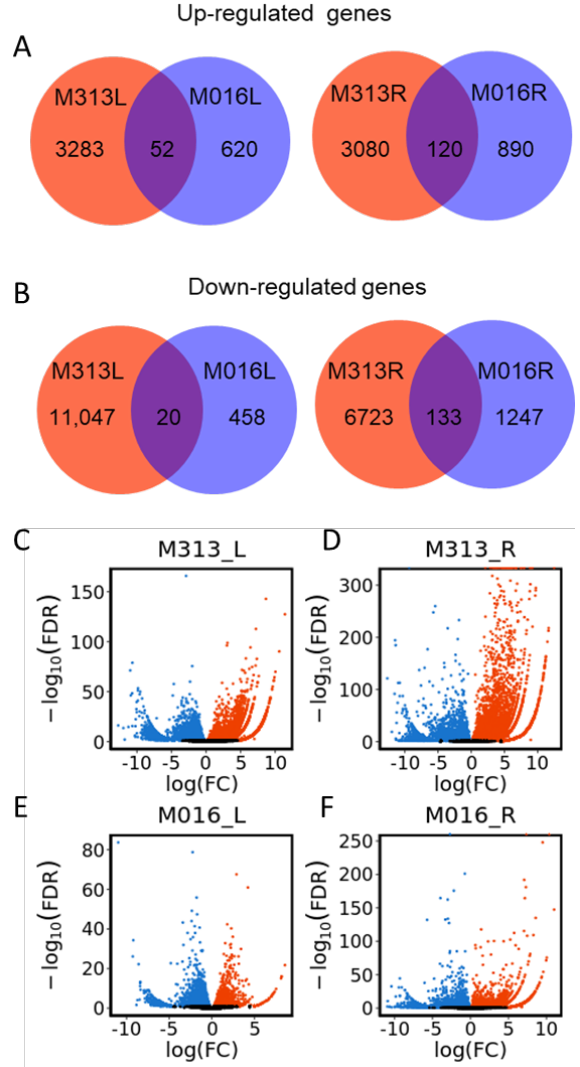
Figure 1. Analysis of DEGs in leaves and roots of M. lutarioriparius with different ploidy levels under drought stress. ( A , B ) Venn diagram of up-regulated ( A ) and down-regulated ( B ) genes in leaves and roots of M. lutarioriparius with different ploidy level. Red circle represents diploid (M313) and blue circle represents tetraploid (M016), L and R represent leaves and roots, respectively. ( C , D ) The volcano plot of the DEGs in the leaves ( C ) and roots ( D ) of diploid. ( E , F ) The volcano plot of the DEGs in the leaves ( E ) and roots ( F ) of tetraploid. Blue dots represent down-regulated genes, the red dots represent up-regulated genes, and the black dots represent genes with no difference between drought treatment and control group.